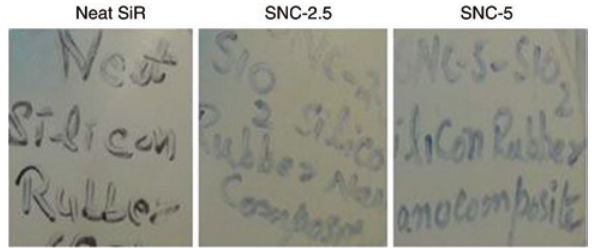
Figure 2: Photographs of virgin samples of neat SiR, SNC-2.5, and